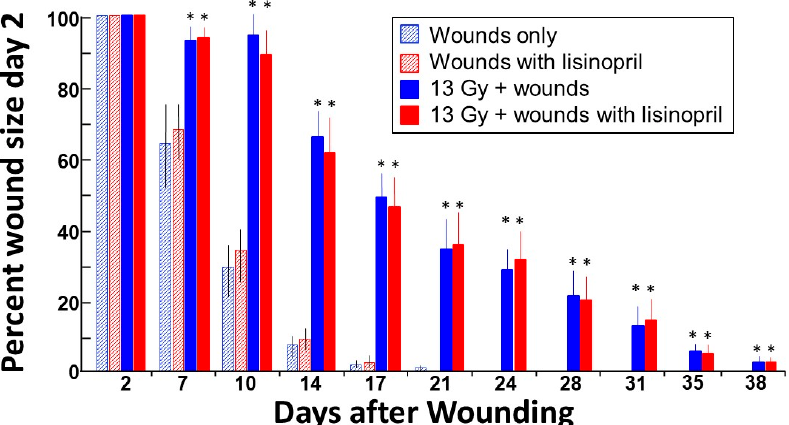
Figure 2. Time course of skin wound healing. All rats received skin wounds on their back as described in Materials and Methods. Wound size was measured on day 2 and fixed to 100% (Y-axis). The percent of this area that remained wounded at different time points was assessed twice weekly until the wounds were healed beyond 95%. Irradiation increased wound healing time and lisinopril had no effect on this endpoint. Values are represented as means + 95% confidence intervals. * p < 0.05 vs. corresponding non-irradiated control.